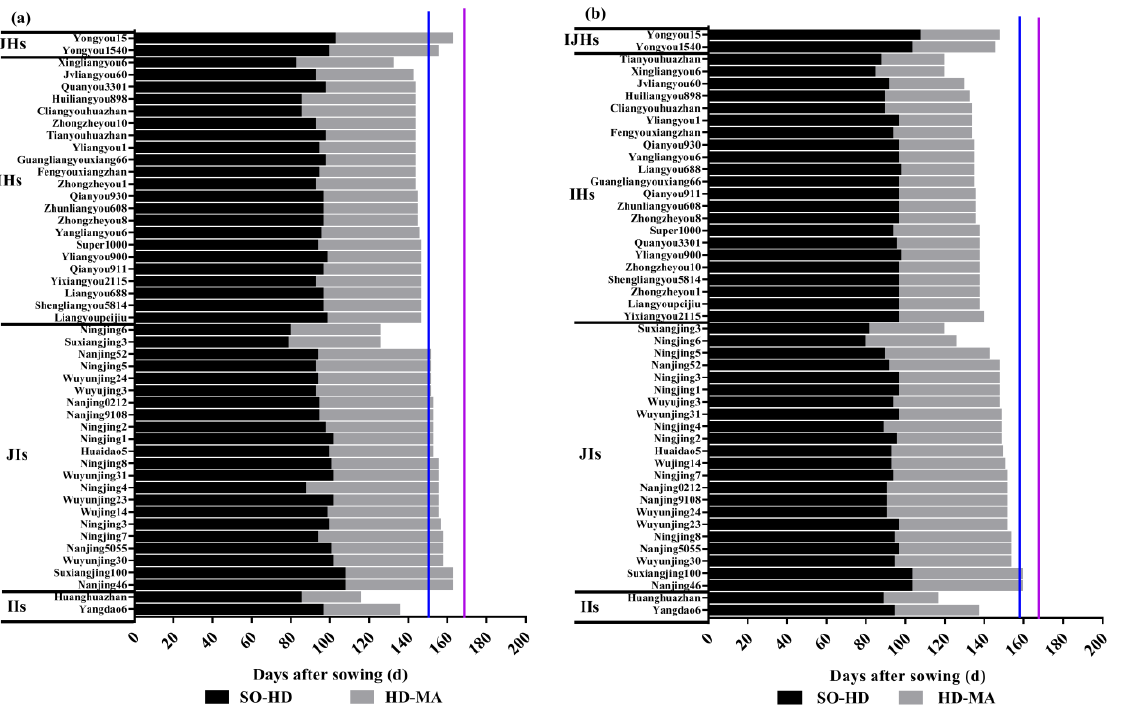
Figure 4. Days from sowing to heading (SO-HD) and days from heading to maturity (HD-MA) for the indica-japonica hybrids (IJHs), indica hybrids (IHs), japonica inbreds (JIs), and indica inbreds (IIs) in 2017 ( a ) and 2018 ( b ), respectively. The blue line represents biological zero temperature (14 ◦ C) for IHs and IIs, and the purple line represents biological zero temperature (12 ◦ C) for JIs and IJHs.